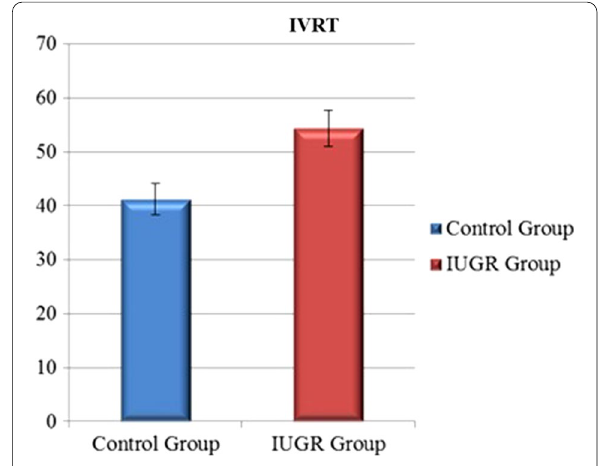
Fig. 1 Comparison between control and IUGR groups according to IVRT